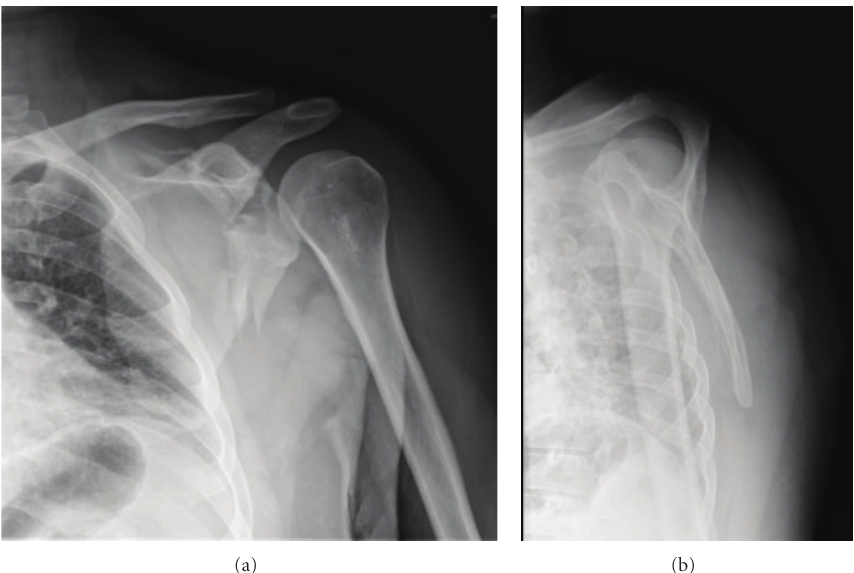
Figure 2: Anteroposterior (a) and lateral (b) radiographs of the left shoulder demonstrating a comminuted fracture of the lateral aspect of the left scapula with glenoid